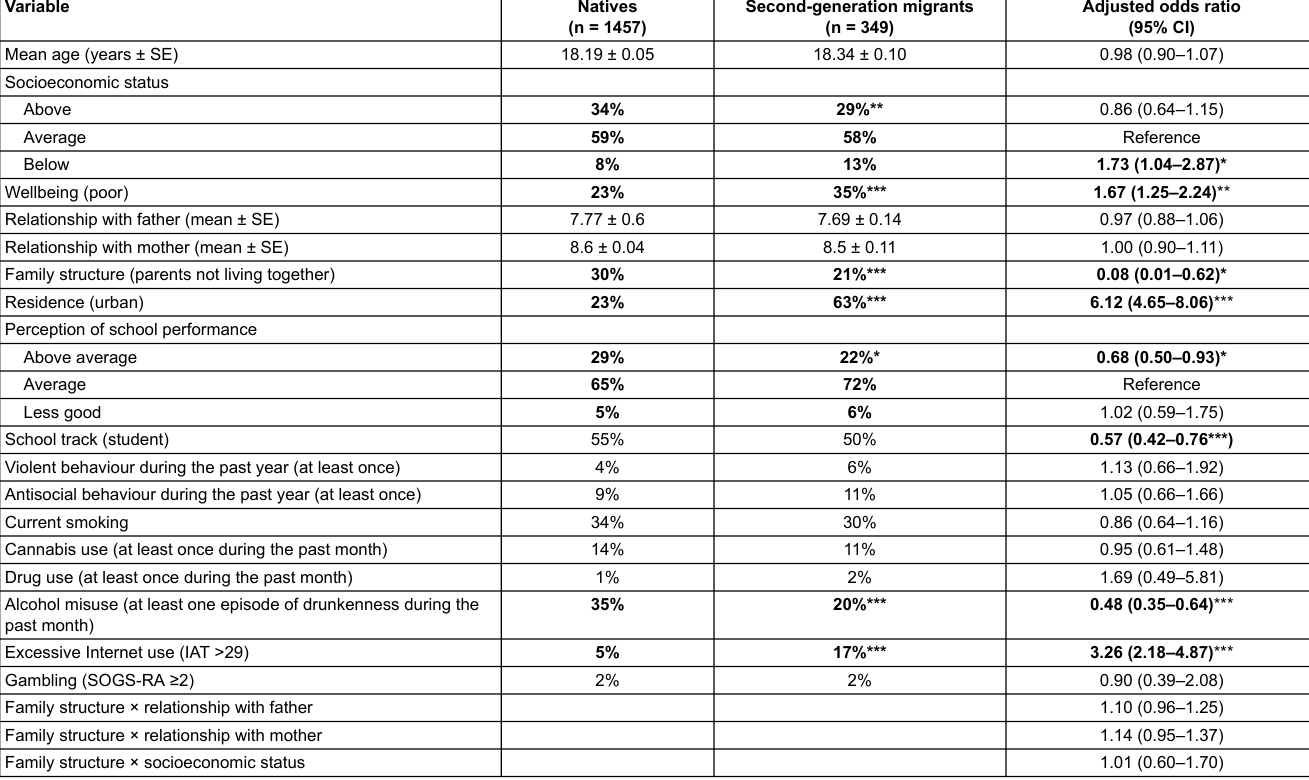
Table 5: Girls: comparison of second-generation migrants vs natives in the age group 15–24 years in post-mandatory schools.